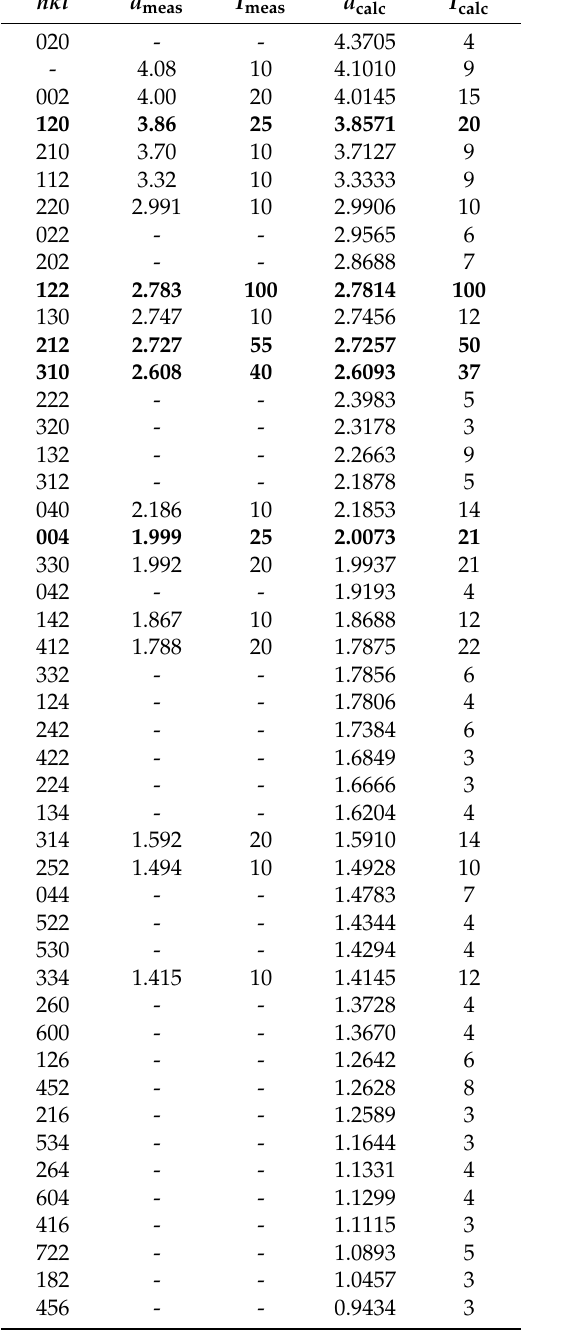
Table 4. Measured and calculated X-ray powder diffraction data (d in Å) for cerromojonite. The strongest measured diffraction lines are given in